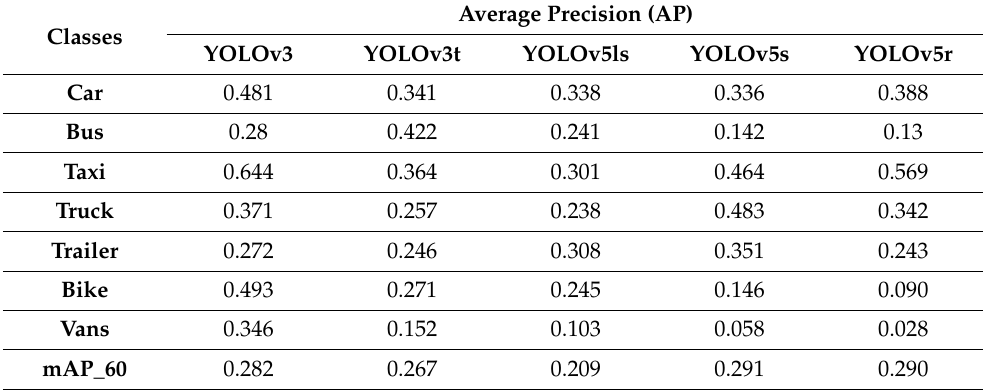
Table 5. Performance characteristics of YOLO networks on SR1 training sets and evaluating data from fine-tuned SR2 test